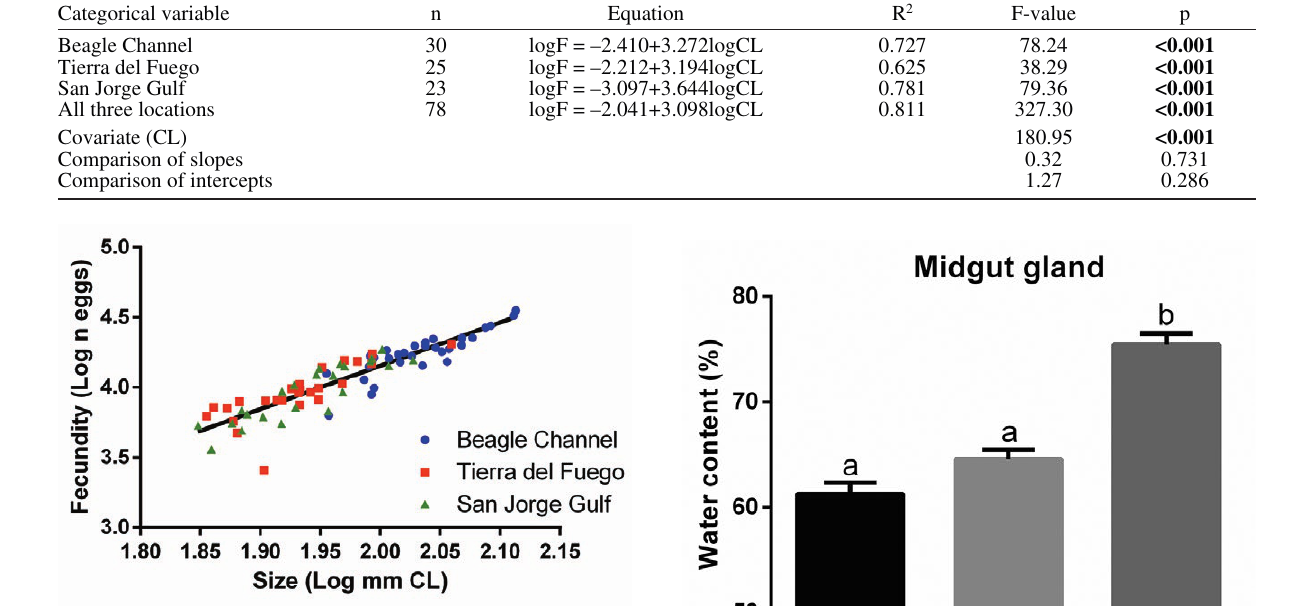
Fig. 2. – Fecundity and female size of L. santolla from the three sampling sites. A single regression fits the data from all locations, as no significant differences were found in the fecundity-size relation between sites (ANCOVA, p>0.05). Fecundity and size values were log-transformed.